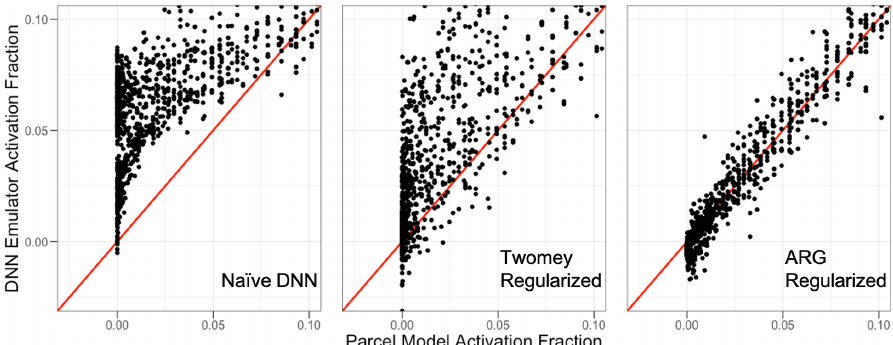
Figure 4. Scatterplots for the various DNN emulator types against the parcel model activation fraction for cases with activation fractions below 0.1. The 1 : 1 line is shown in red.